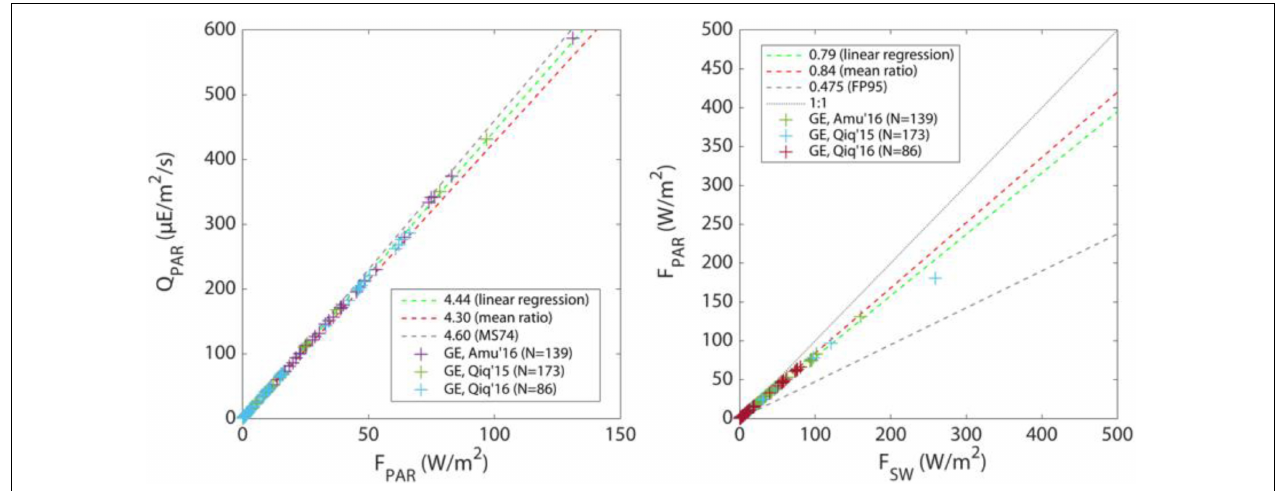
FIGURE 2 | Observational constraints on the conversion from solar energy to visible quanta in ice-covered environments, based on spectral irradiance observations collected in the framework of GreenEdge (GE) program (+), and as retrieved from linear fits (lines). The left panel depicts the relationship in the visible range between quanta ( Q PAR ) and energy ( F PAR ). The right panel depicts the relationship between energy in the visible range ( F PAR ) versus energy in the solar range ( F SW ). Observational values (+) are split between the two landfast sea ice camps in Qiqitarjuak (Qiq’15 and Qiq’16) and the drift ice cruise onboard the R/V Amundsen in Baffin Bay (Amu’16). Linear fits use coefficients corresponding to observation-based values (linear regression coefficient and mean ratio) and to classically used values, corresponding to open water situation (Morel and Smith, 1974 , MS74; and Frouin and Pinker, 1995 ,